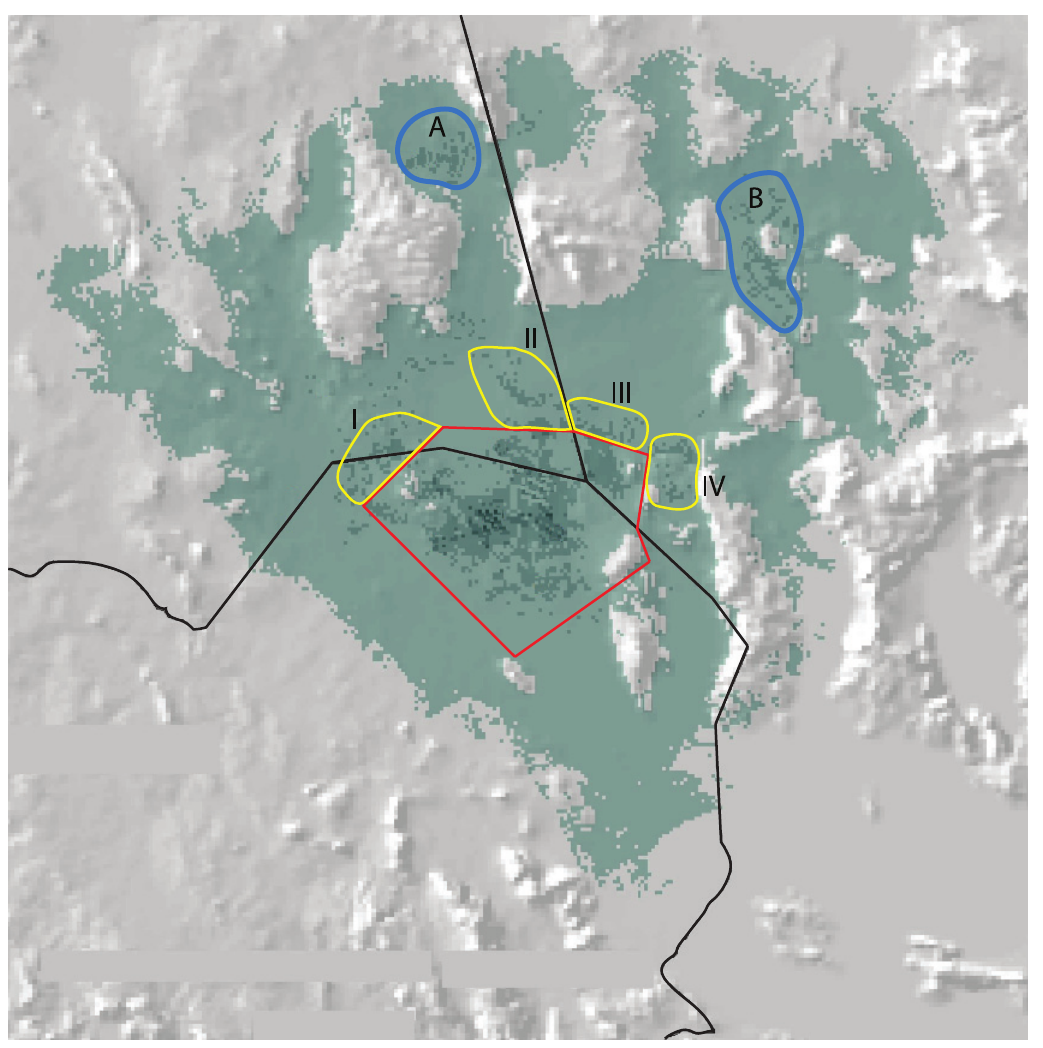
Fig 4. Proposed key sites (yellow polygons) for the conservation of the Bolson tortoise, Gopherus flavomarginatus . The red line delineates the current protected polygon of the Mapimí Biosphere Reserve. Sierra del Diablo (A) and Sierra Mojada (B) represent putative high abundance sites; nonetheless, these are low priority areas due to their natural isolation and low human population